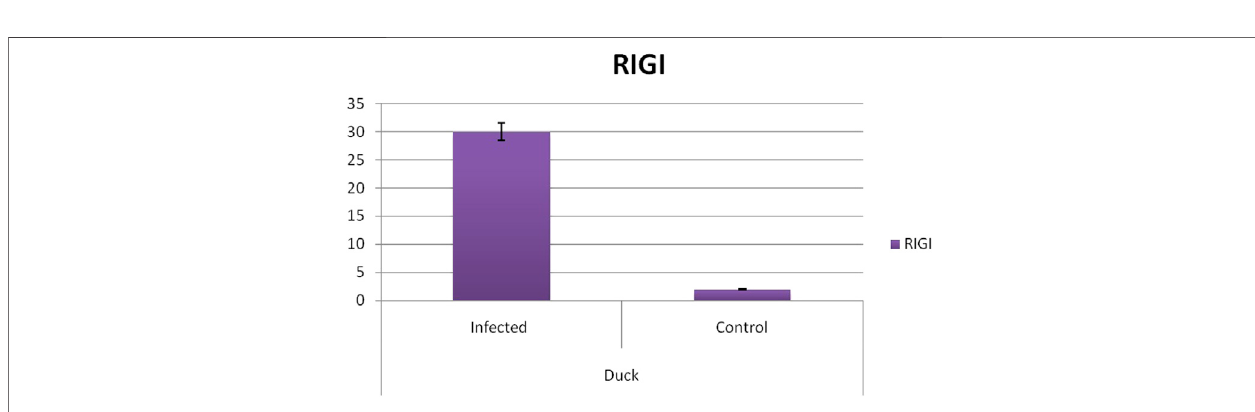
Frontiers in Molecular Biosciences |